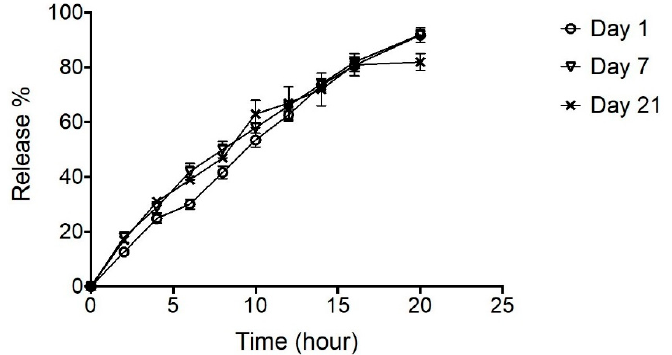
Figure 9. In vitro release of insulin (NPH- PF127 25%) at day 1, 7, and 21 upon storage at 4 °C. Data are expressed as means ± S.D. ( n = 3).